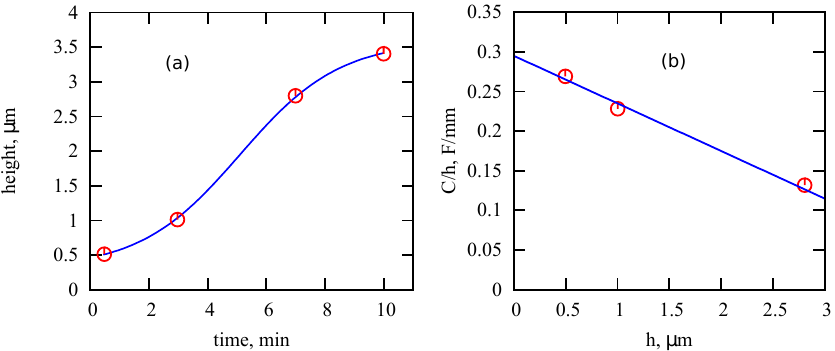
Figure 7. Dependence of MWCNT height on duration of array synthesis ( a ) and the efficiency of using the MWCNT array height for the device capacitance ( b ). Circles correspond to experimental data, lines are approximation by a cubic polynomial function ( a ) and a linear function ( b ).